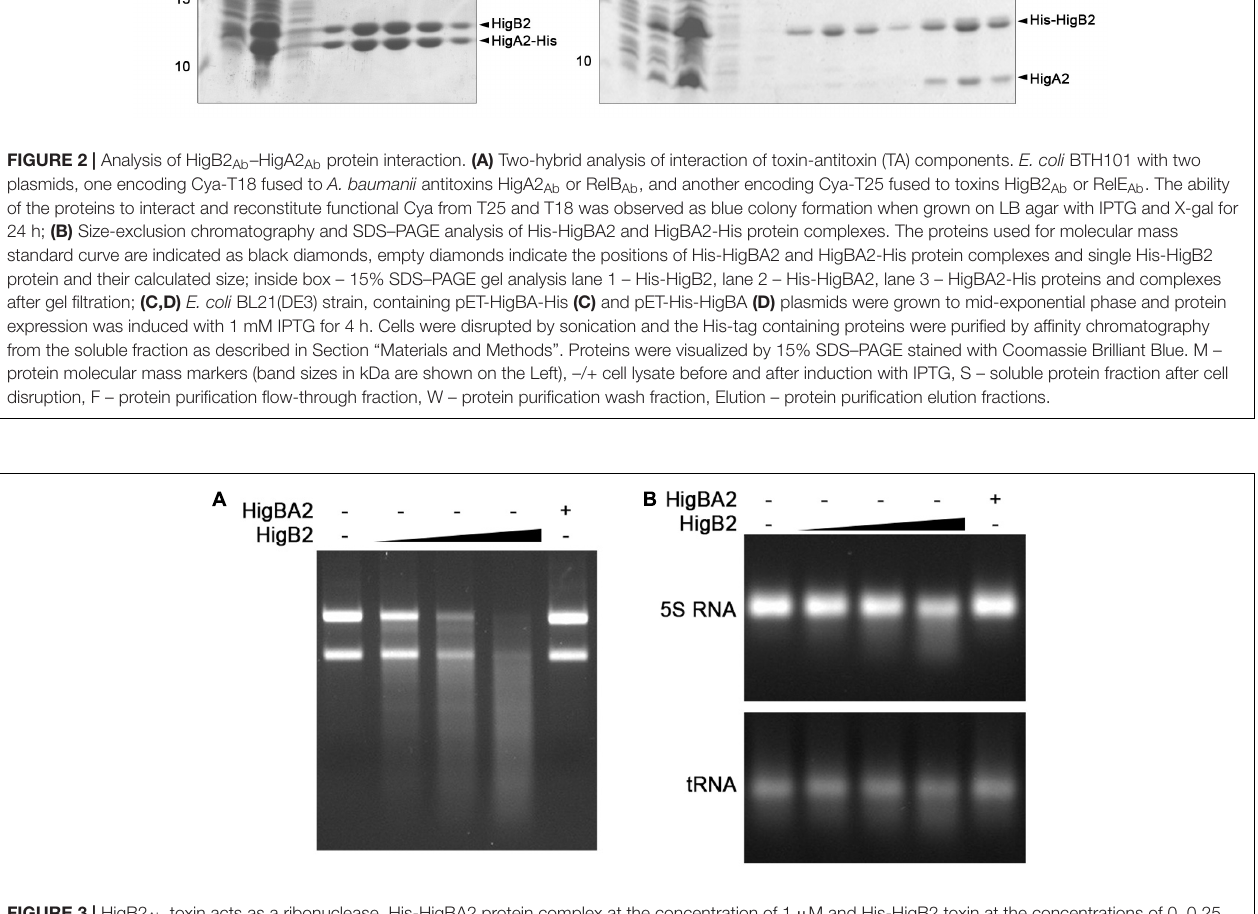
FIGURE 3 | HigB2 Ab toxin acts as a ribonuclease. His-HigBA2 protein complex at the concentration of 1 µ M and His-HigB2 toxin at the concentrations of 0, 0.25, 0.5, and 1 µ M, were incubated with 1.5 µ g of total A. baumannii RNA (A) and with 3 µ g of E. coli 5S rRNA (B) in 10 µ l reactions for 30 min at 37 ◦ C. The samples were visualized in 1% agarose